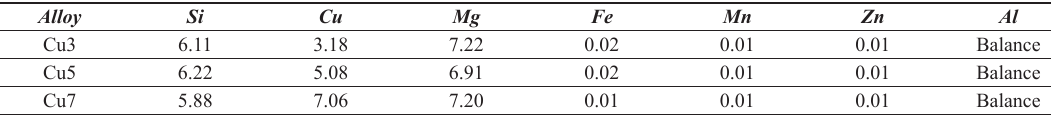
Table 1. Chemical composition (in wt.%) of the experimental